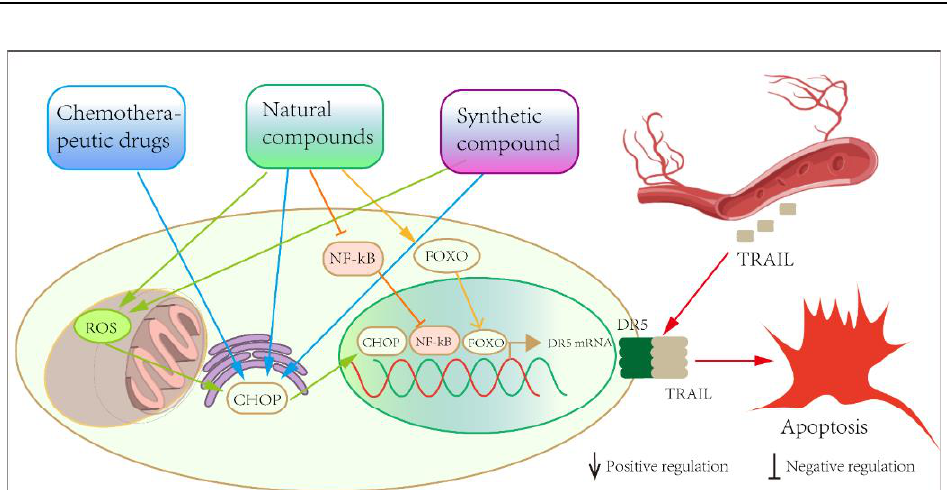
Figure 4. Overview of the mode of action of small-molecule compounds in regulating DR5-induced apoptosis.